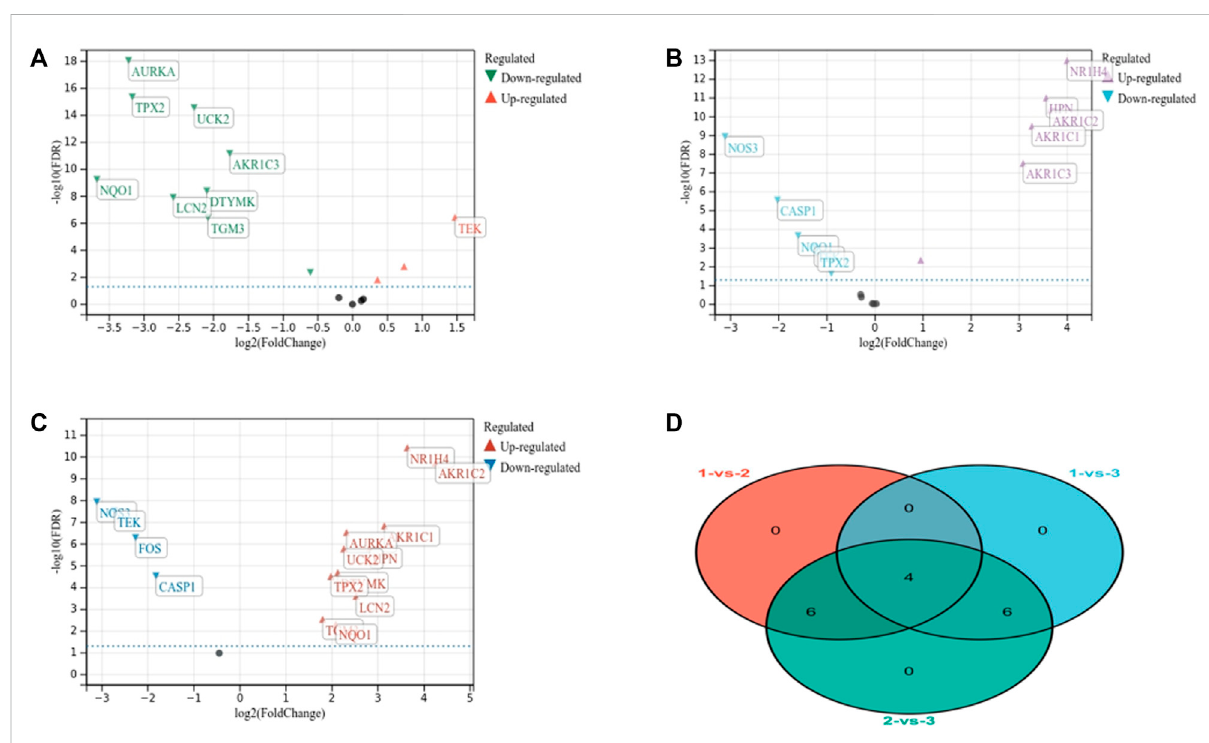
FIGURE 2 GO and KEGG enrichment analysis. (A) Biological process. (B) Cellular components. (C) Molecular function. (D) KEGG